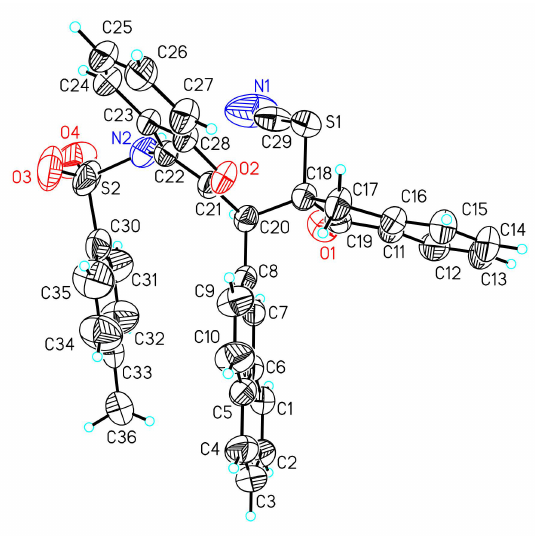
Figure 4. X-ray crystal structure of 3ja